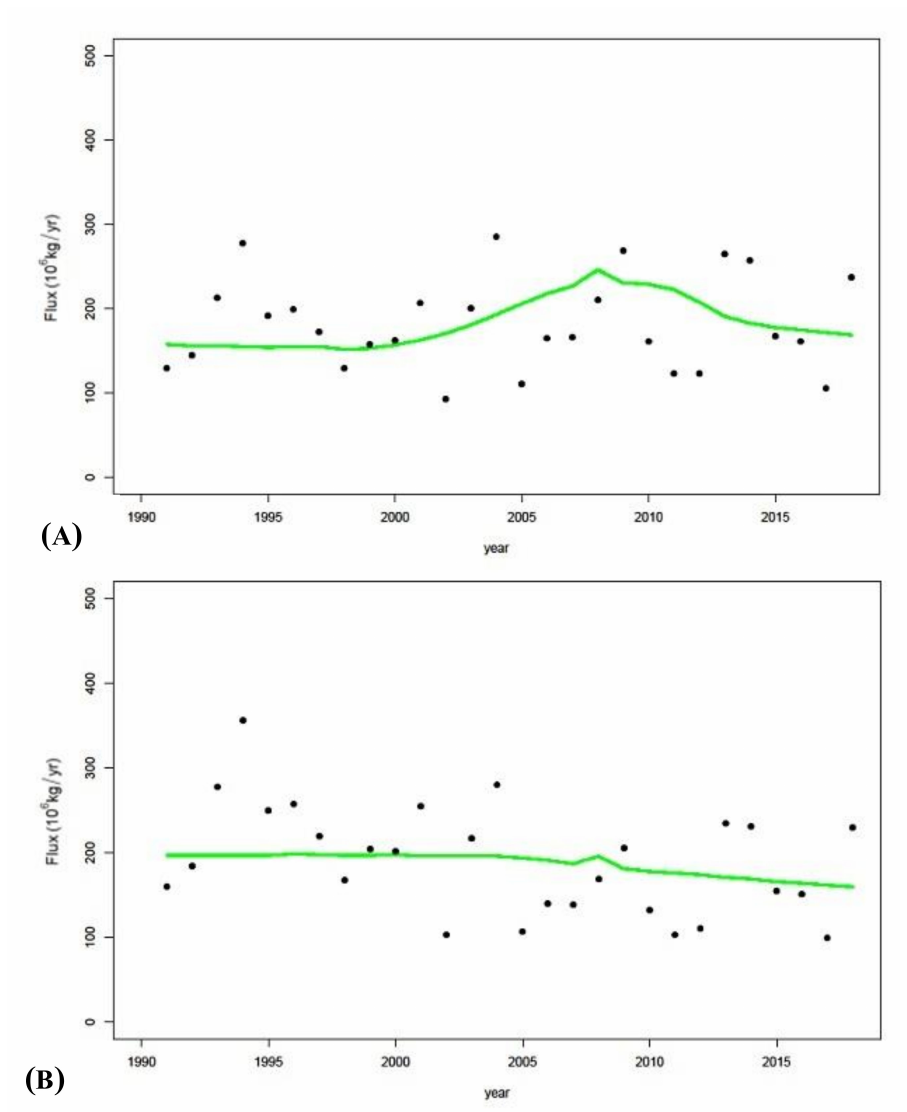
Figure 9. Predicted change in nitrate fluxes for the 1990–2017 period with no random ( A ) and no systematic ( B ) variations for the Garonne